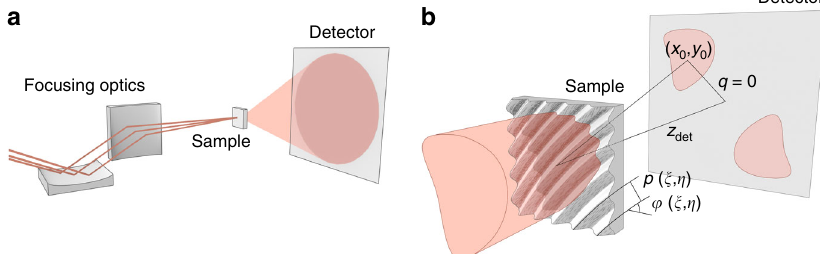
Fig. 2 Experiment geometry and sample design. a An optical system focuses the incoming beam (red lines) onto the sample. Downstream, a 2D pixelated detector records the scattered radiation (red cone). b Enlarged view of the sample and the scattering geometry. The sample bears a suitably tailored, continuously varying grating with local periodicity p ( ξ , η ) and local orientation angle φ ( ξ , η ), where ξ and η are the coordinates in the sample plane. Incident light is diffracted away from the unde fl ected beam ( q = 0) with a momentum transfer of ± q ( p , φ ) according to the local grating parameters. We design the grating such that it maps an enlarged image of the incident illumination, centered around ± ( x 0 , y 0 ) in the detector plane at distance z det.